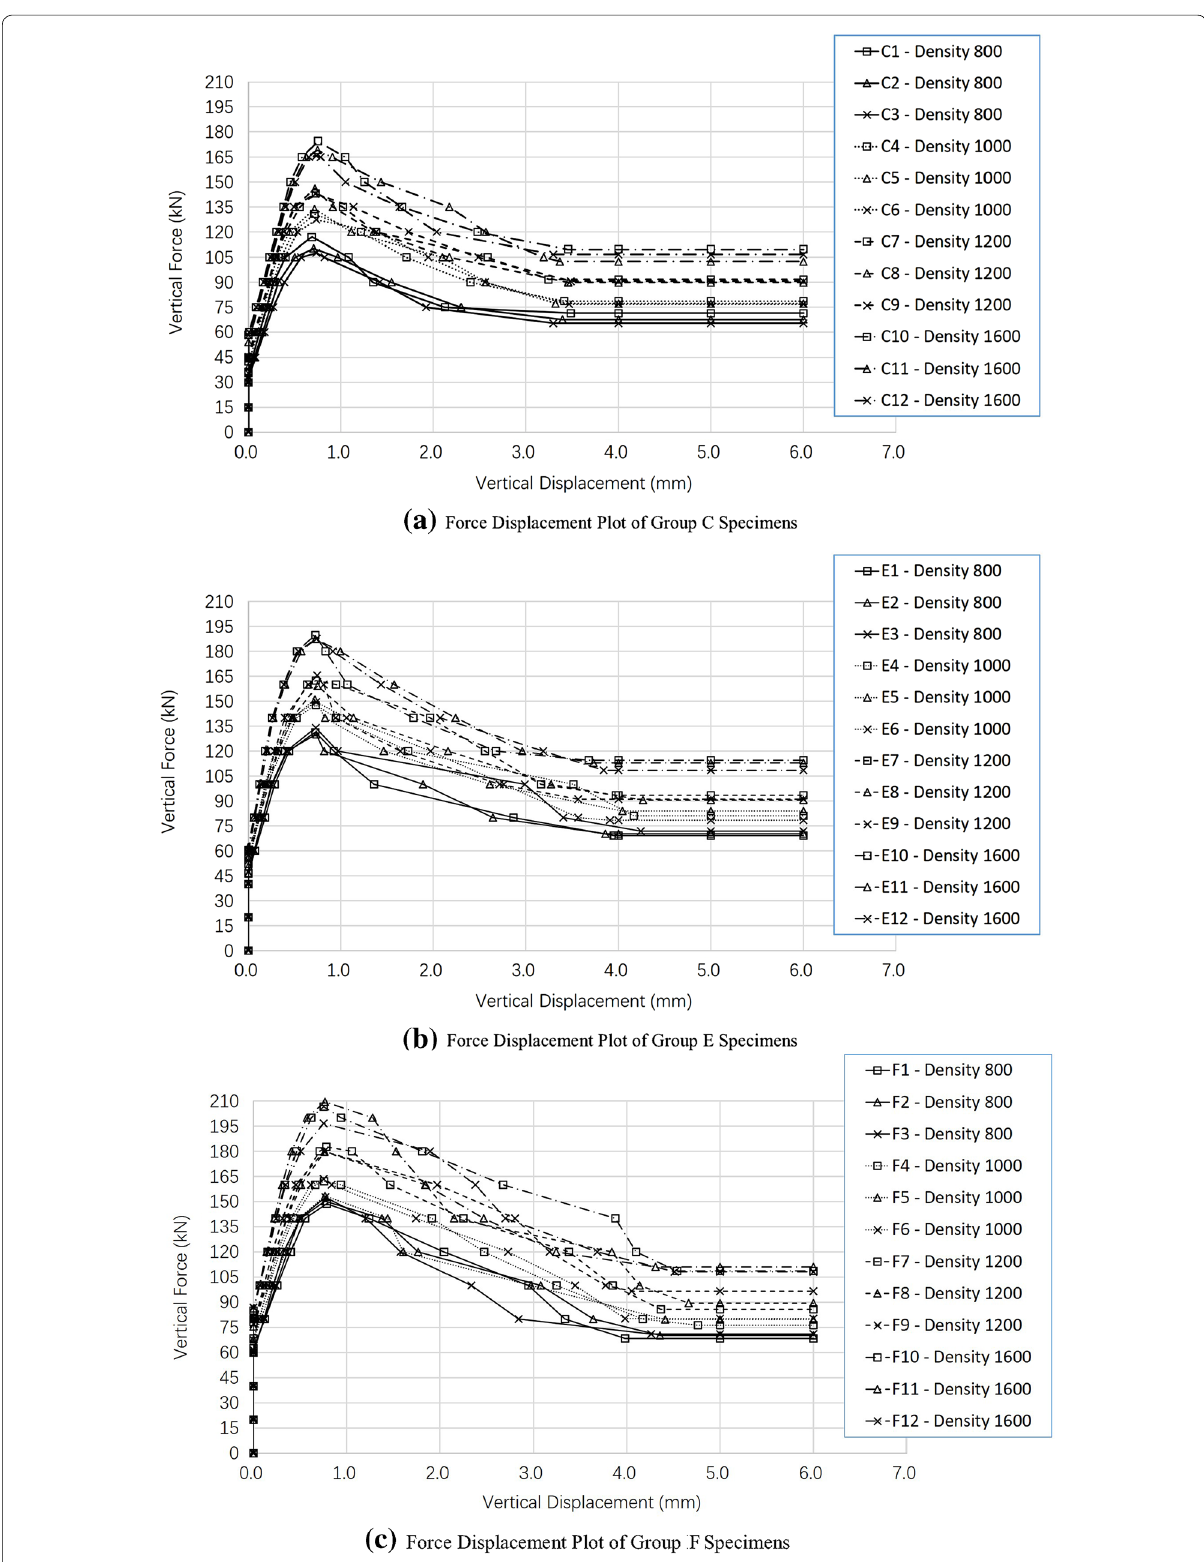
Fig. 4 Force displacement plot of all